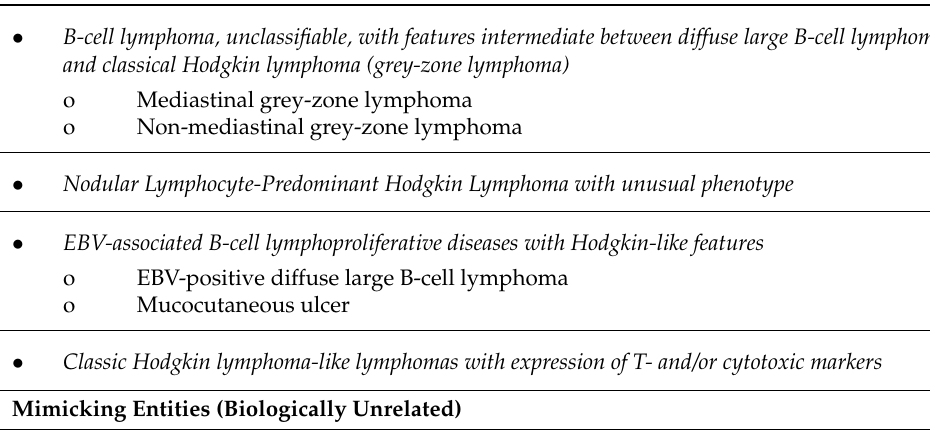
Table 1. The grey zones of classic Hodgkin